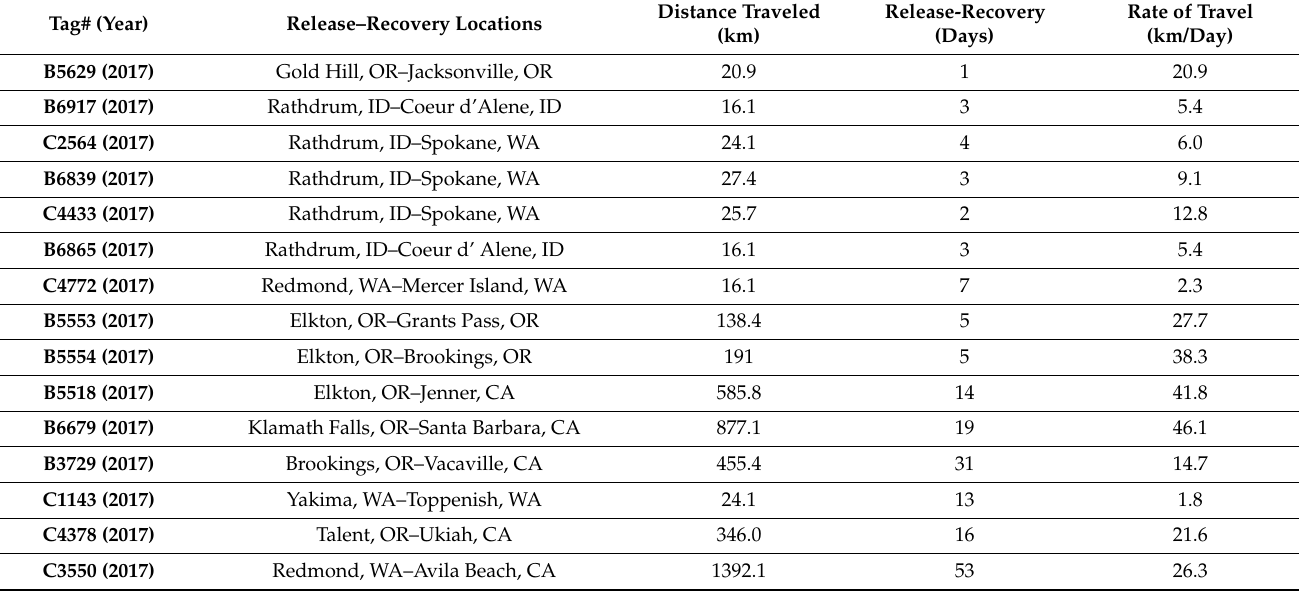
Table 8. Distance and daily rate of travel of captive-reared-tagged fall-migrating monarchs during 2017–2019. Tag#